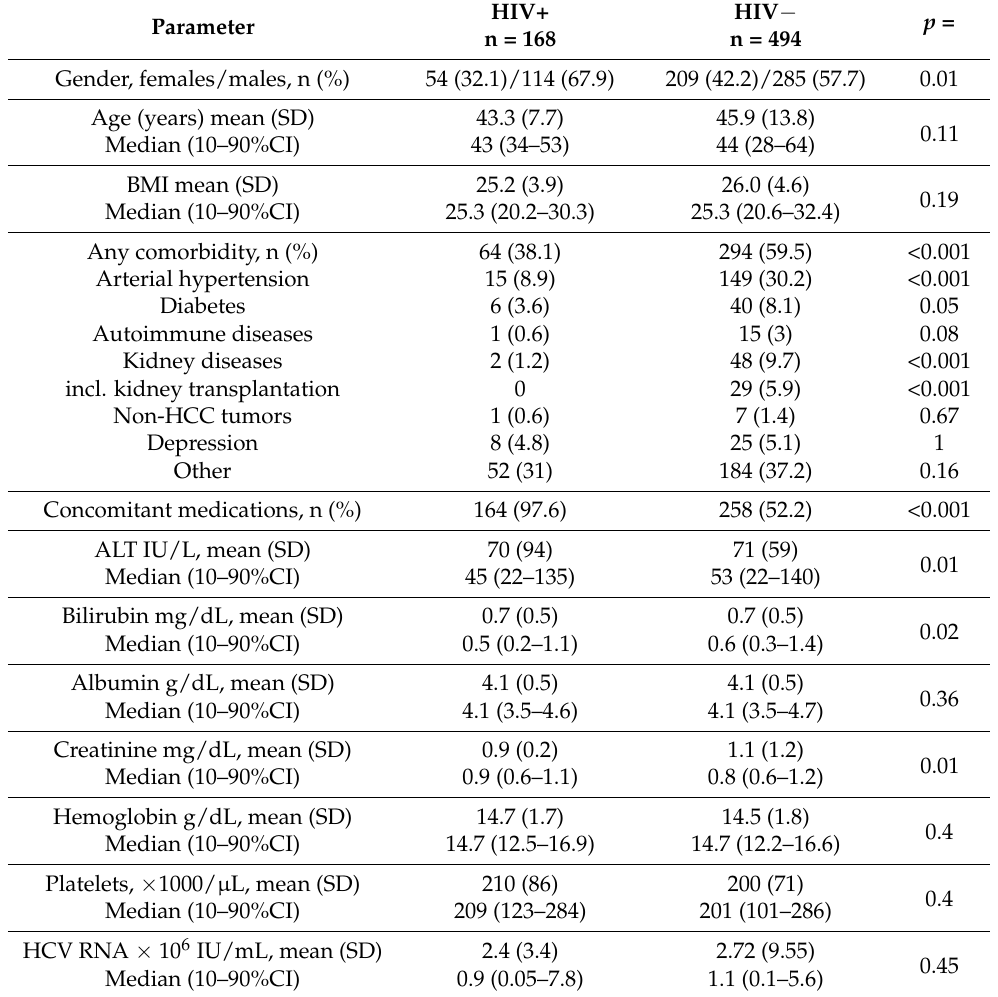
Table 1. Baseline characteristics of GT4-infected patients depending on the HIV status.